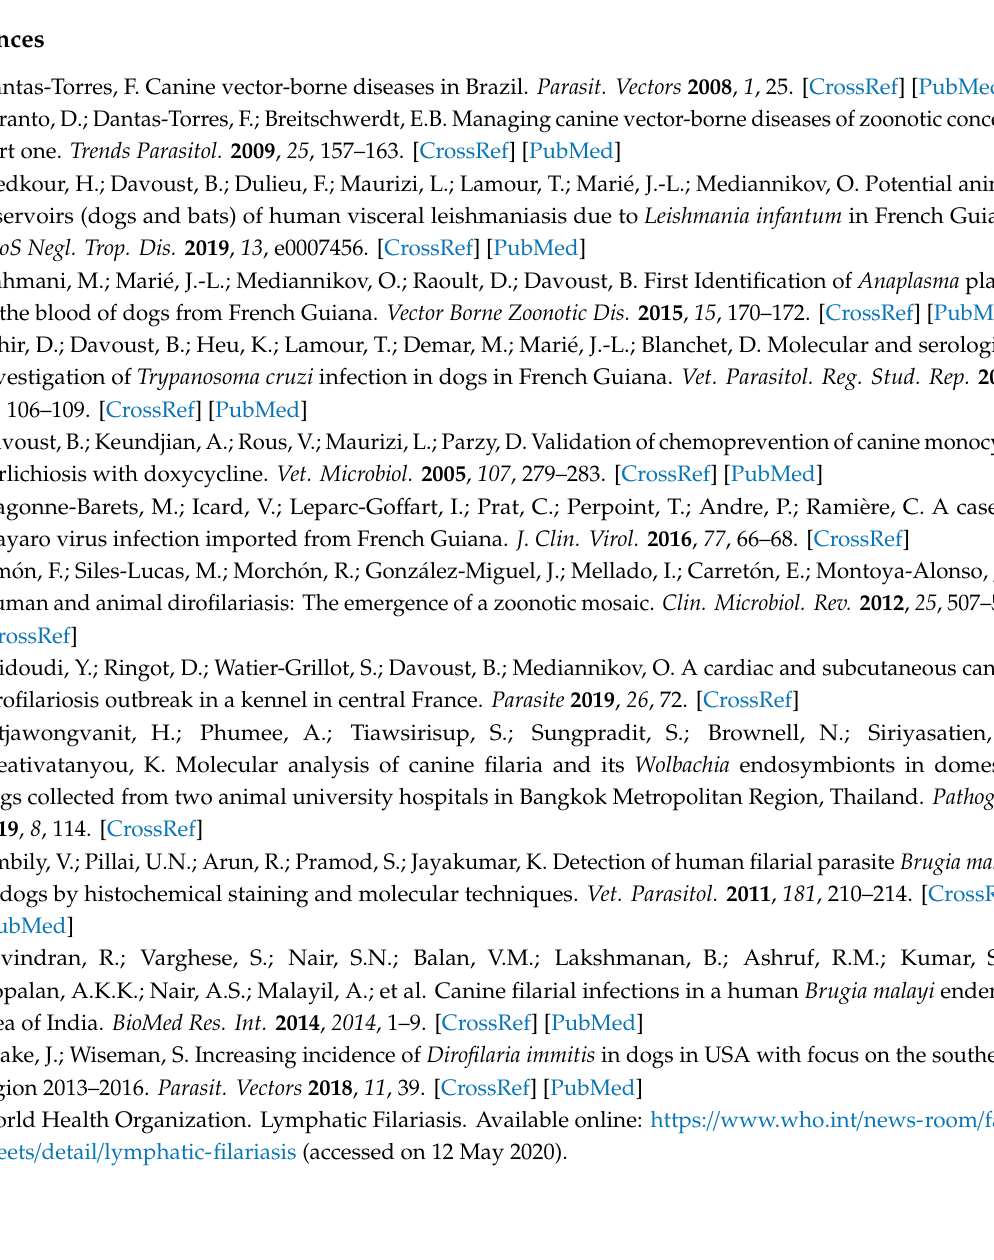
Table S1: PCR / Sequencing results of the